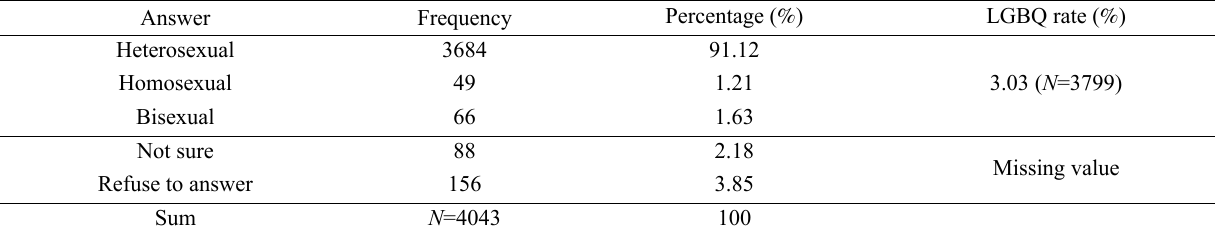
Table 1 Frequency and percentage for sexual orientation in the